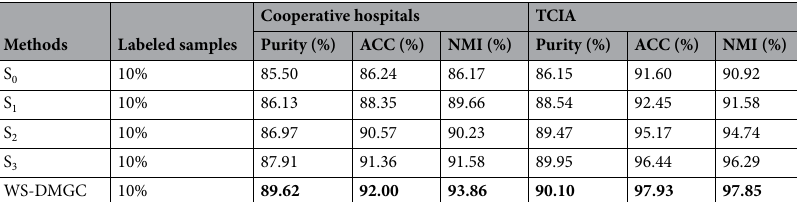
Table 1. Evalutation metric on TCIA and cooperative hospitals dataset (bold indicates best).